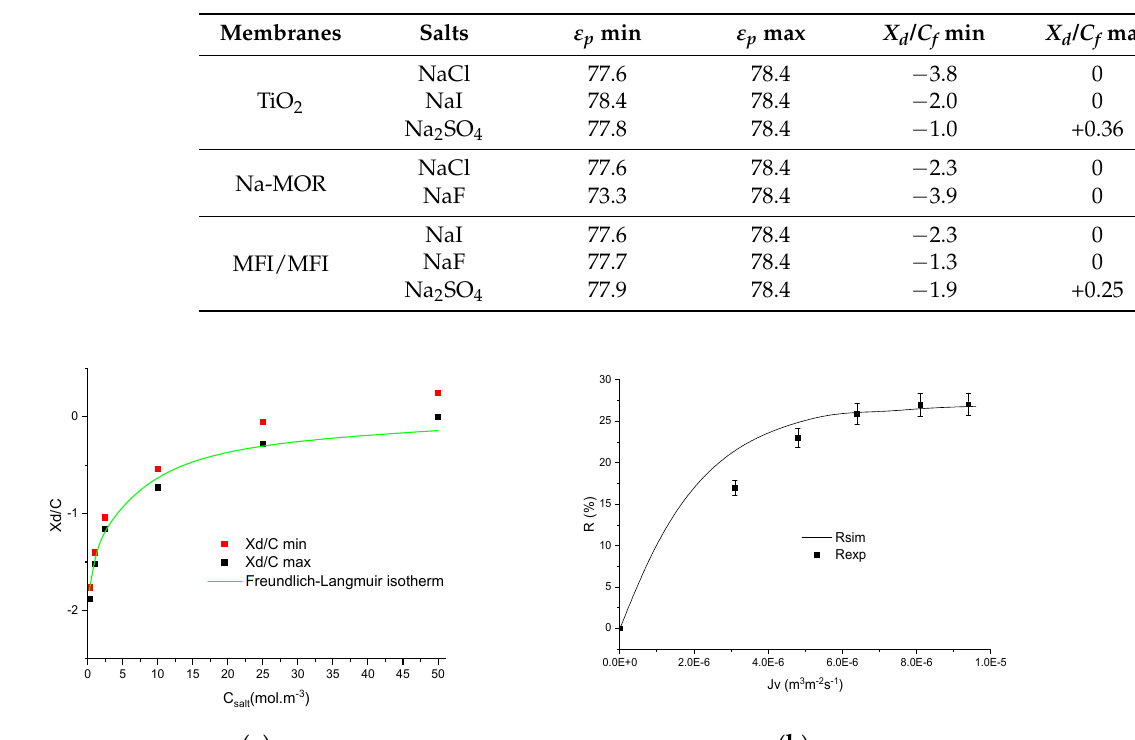
Table 3. Minimum and maximum values of ε p and X d / C f estimated with the various salts